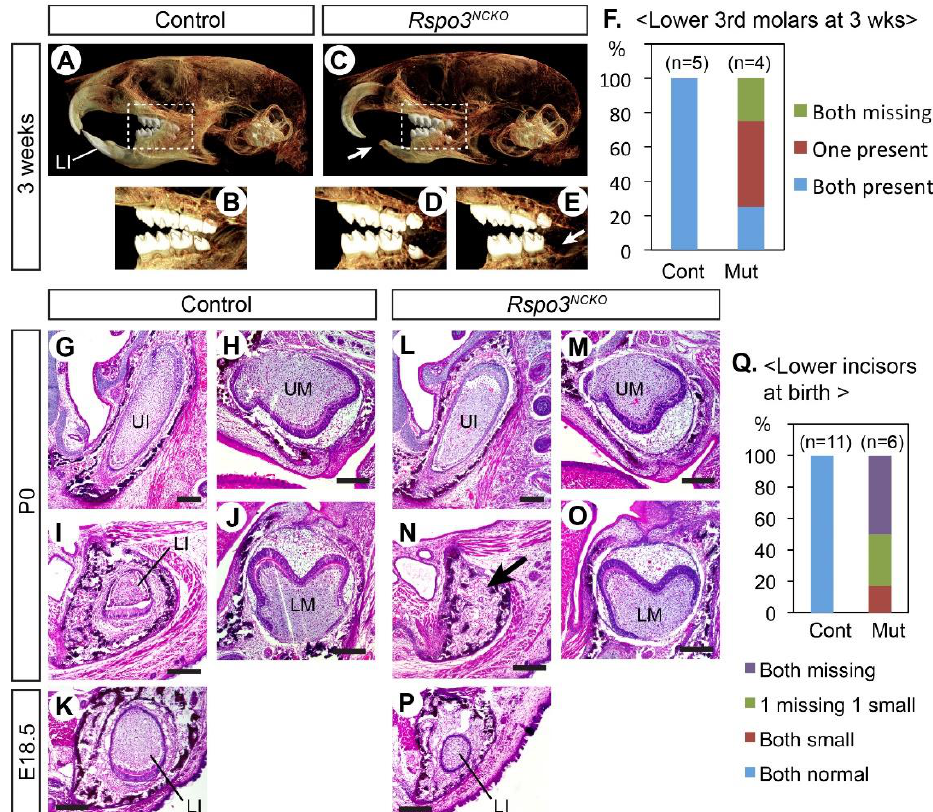
Figure 1. Dental phenotype of Rspo3 NCKO mutants. ( A – E ) Micro-CT images of the head. A total of 9 animals were examined (5 controls and 4 mutants). Arrows in ( C , E ) point to the missing teeth. ( F ) Summary of the lower third molar phenotype. ( G – P ) Coronal sections of the head stained with hematoxylin and eosin. Total 17 animals were examined (11 controls and 6 mutants). The arrow in ( N ) points to the absence of the lower incisor. ( Q ) Summary of the lower incisor phenotype. LI: lower incisor; LM: lower molar; UI: upper incisor; UM: upper molar. Bar: 0.2 mm. Genotypes of the controls shown are Wnt1-Cre ( A , B ) and Rspo2 +/ − ;Rspo3 fl/+ ( G – K ).